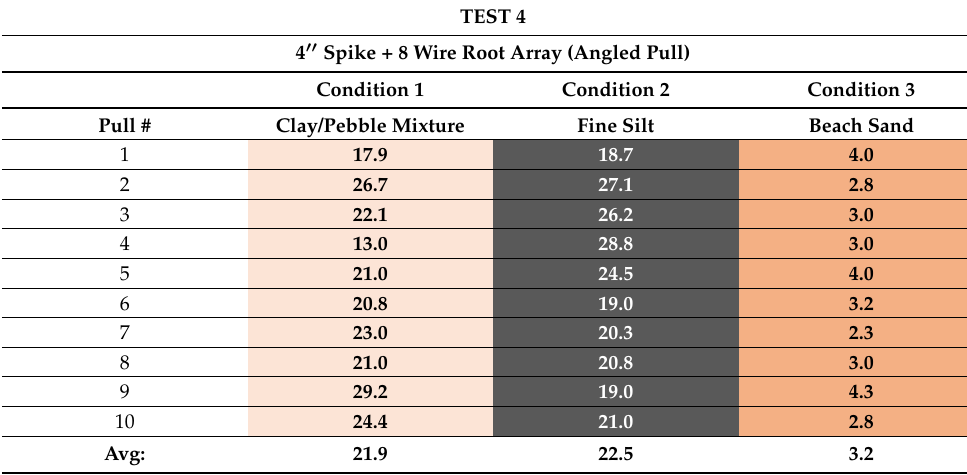
Table A4. Test 4: complete anchoring failure tension data